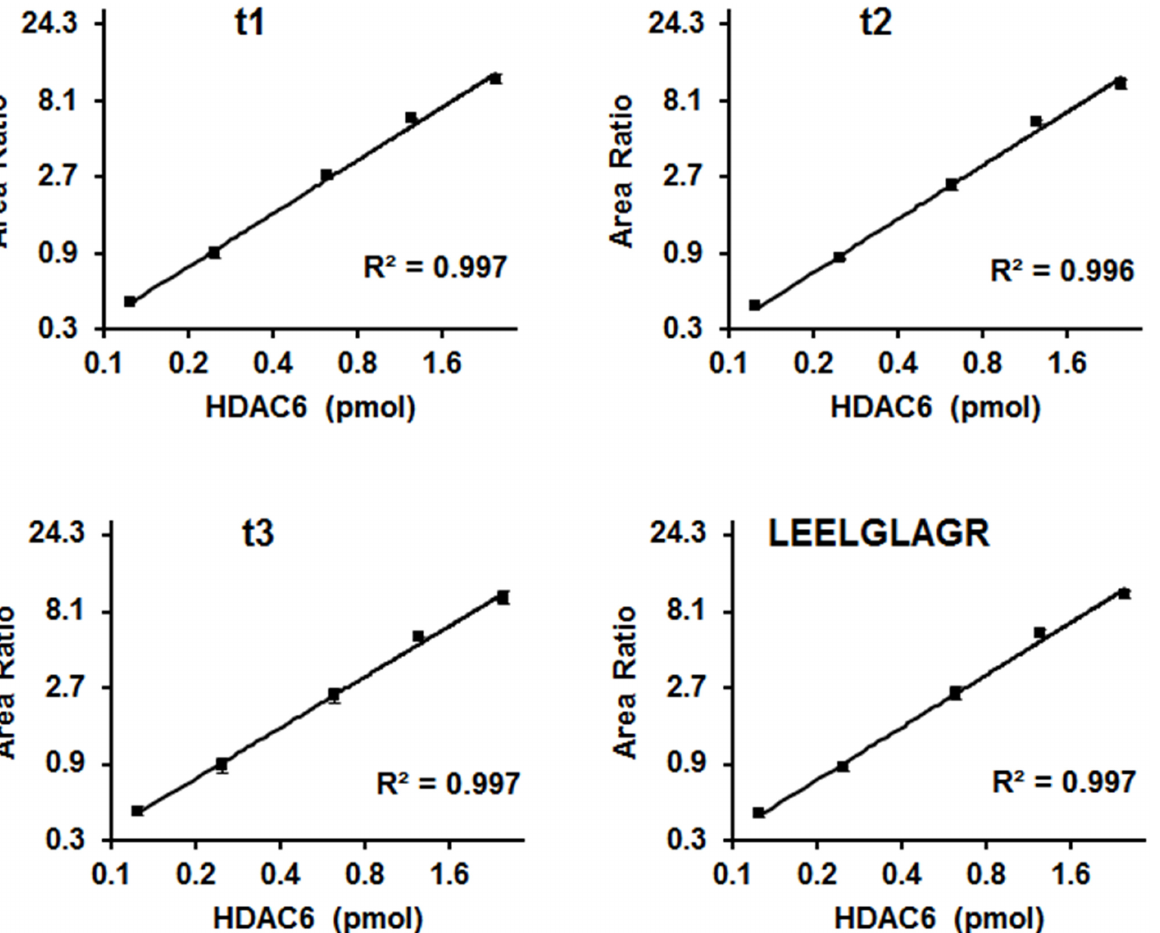
Fig 2. Calibration curves for quantification of peptide LEELGLAGR from HDAC6 standard using 15 N-labeled peptide from QconCAT#2 as internal standard. Area ratio of 14 N-LEELGLAGR to 15 N-LEELGLAGR for each of the three transitions for quantification was plotted versus pmol of HDAC6 standard. Individual transitions shown are ( t1 ) 479.3/586.4 and 485.3/595.3, ( t2 ) 479.3/715.4 and 485.3/725.4, ( t3 ) 479.3/586.4 and 485.3/595.3. Three replicates for each were collected and presented as mean ± SD. Consensus for t1 – t3 is represented in LEELGLAGR